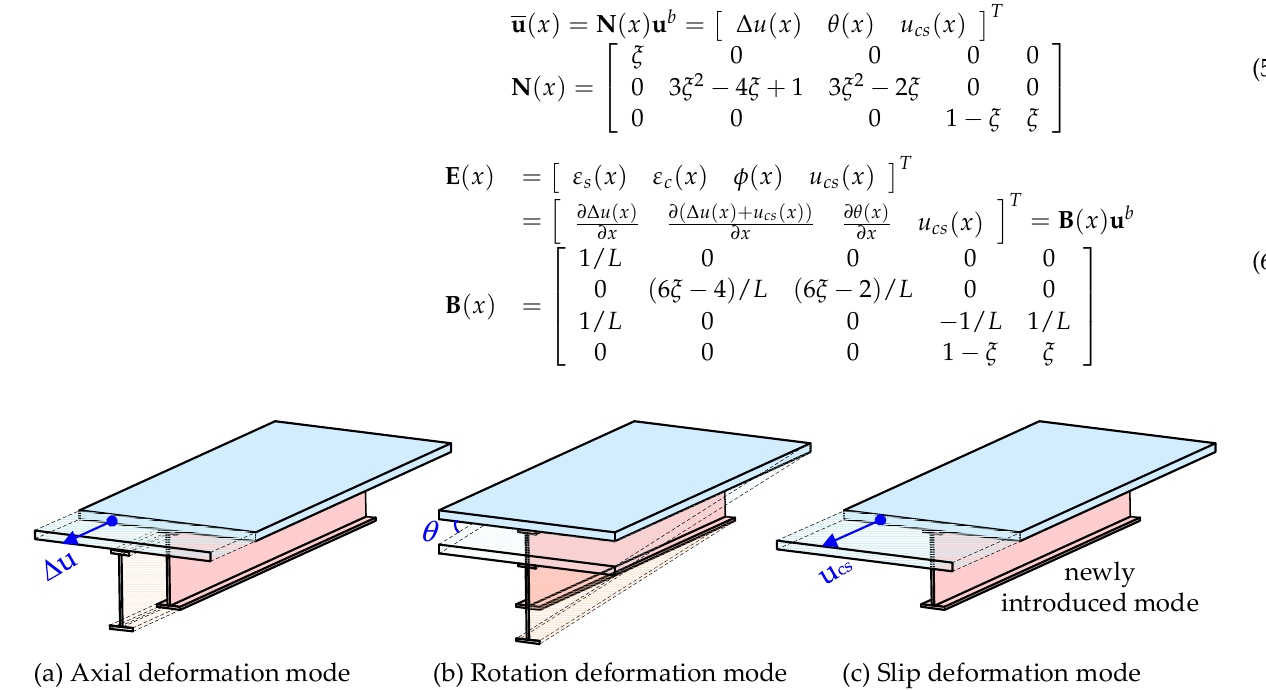
Figure 2. Fiber beam element and fiber section definition.